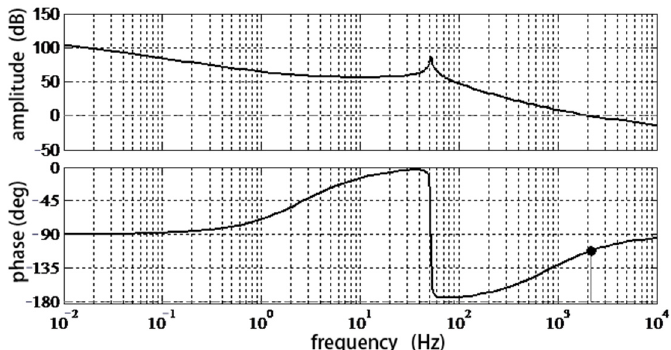
Figure 4. Open-loop transfer function Bode plots of load simulation control algorithm after PI correction.